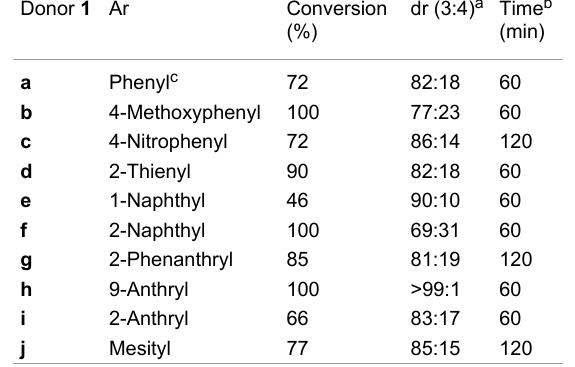
Table 2: Remote chiral induction in the conjugate addition of lithiated α-sulfonylallyl anions of 1 to ethyl crotonate ( 2